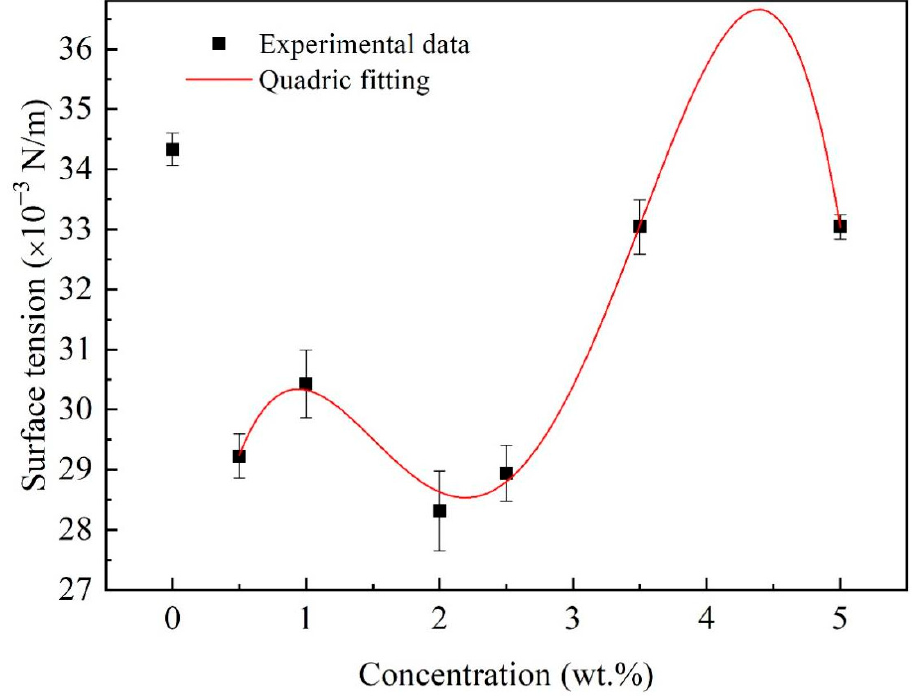
Figure 7. Surface tension of Al/JP-10/oleic acid nanofluid fuels at different Al concentrations.